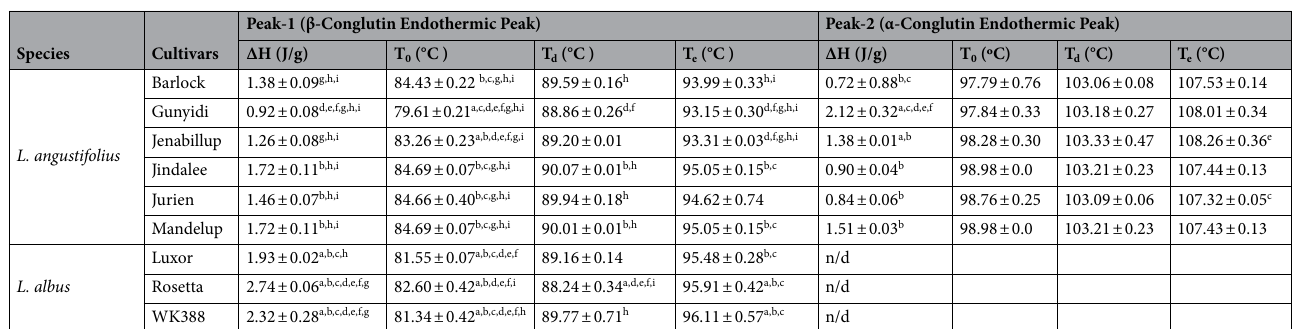
Table 4. Thermal analysis of different lupin cultivars. Data are means of three replicates with standard deviations (SD); n/d (Not detected). Data within the same column with different superscripts are significantly different, pair-wise comparison by Post Hoc Tukey test ( a P < 0.05 vs. Barlock; b P < 0.05 vs. Gunyidi; c P < 0.05 vs Jenabillup; d P < 0.05 vs. Jindalee; e P < 0.05 vs Jurien; f P < 0.05 vs. Mandelup; g P < 0.05 vs Luxor; h P < 0.05 vs Rosetta; i P < 0.05 vs